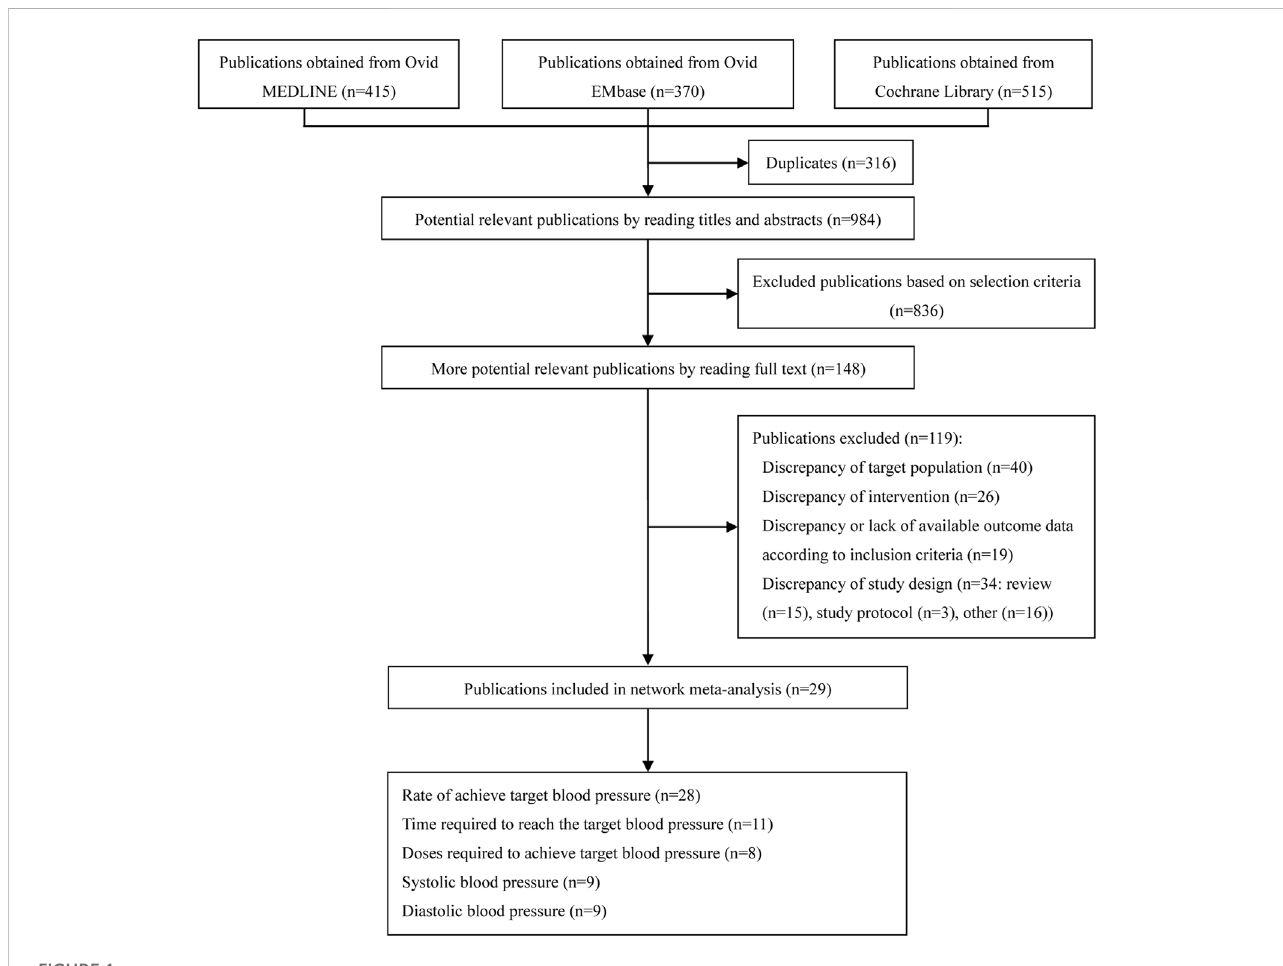
FIGURE 1 PRISMA fl ow